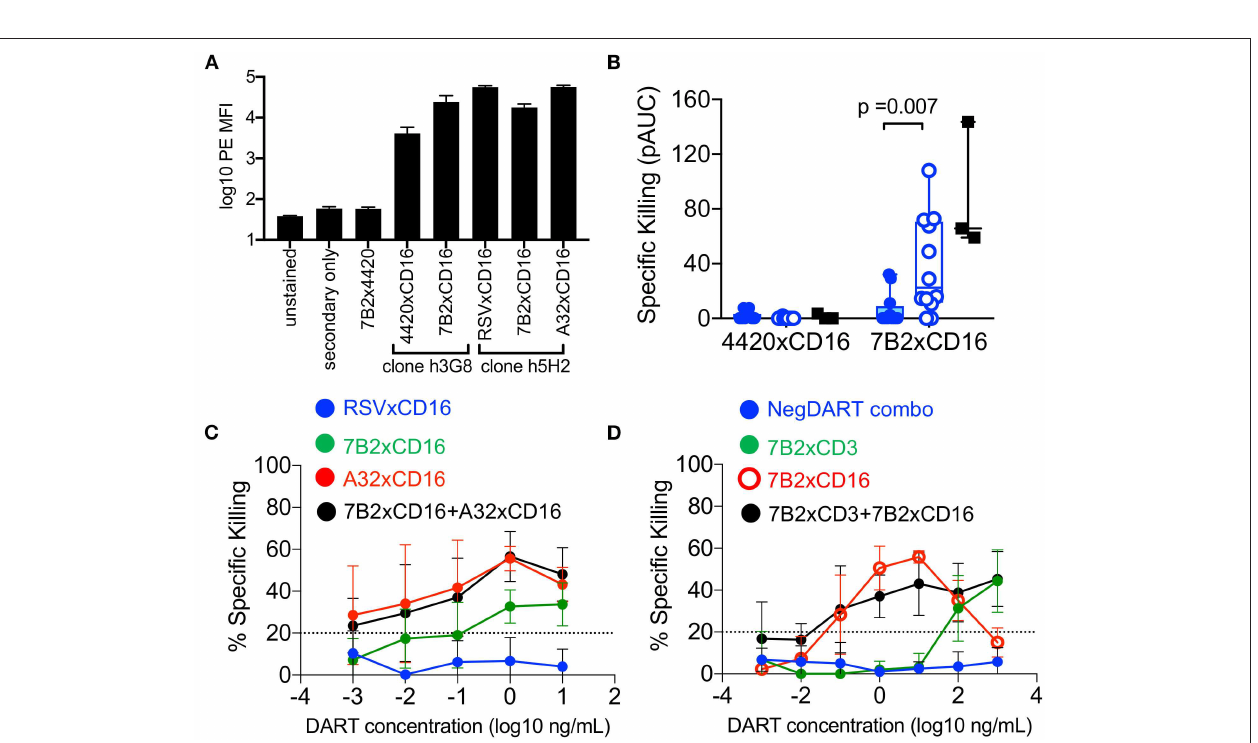
FIGURE 6 | were combined and included in the flow cytometry plots shown. (B) Comparison of NK cell subset frequencies between untreated, and after overnight treatment with 10ng/mL IL-15 ( n = 15 CBMC and n = 15 PBMC samples per condition). Frequencies of total NK cells expressing (C) CD57, (D) CD62L, (E) , HLA-DR, and (F) CD69 in cells left untreated or treated overnight with 10ng/mL IL-15. Amount of intracellular (G) Perforin and (H) Granzyme B in NK cells left untreated or after overnight treatment with 10ng/mL IL-15, measured by antibody binding capacity (see Methods). In (B–H) , box plots represent the interquartile ranges, horizontal lines indicate the medians, and error bars extend to the minimum and maximum observed values.